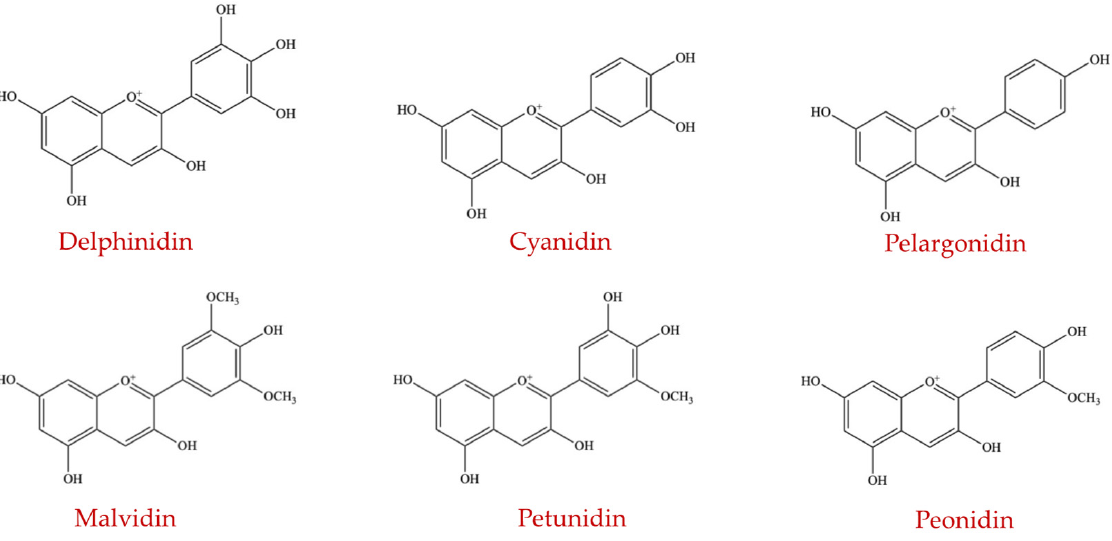
Figure 10. Chemical structures of anthocyanins (delphinidin, cyanidin, pelargonidin, malvidin, petunidin, and peonidin) (self ‐ generated) .